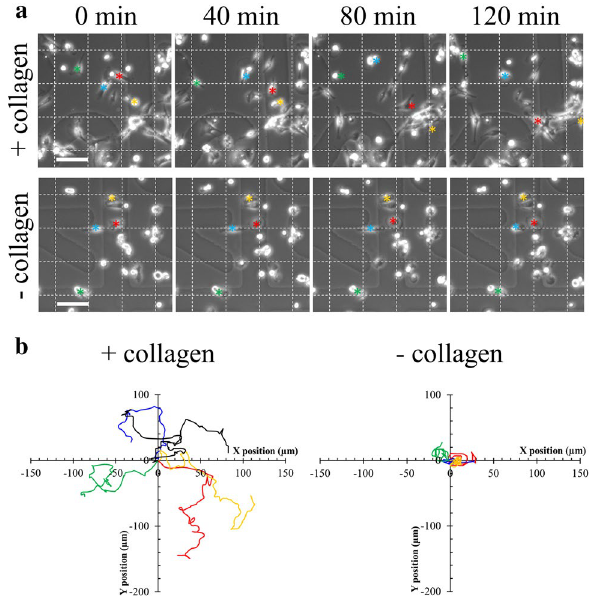
Figure 1. Effect of collagen I fibrils on the migration of MDA-MB-231 cells. ( a ) Kinetics studies by phase- contrast video-microscopy of MDA-MB-231 cells seeded on a glass coverslip coated (top panel) or not (bottom panel) with collagen I. Asterisks (red, blue, green, yellow) correspond to the position of cells of interest in the course of time. Scale bar: 100 µm. ( b ) Tracking analysis of cells presented in ( a ) was performed using MTrackJ plugin from ImageJ software. Relative position of cells migrating during two hours on glass coverslip coated (left panel) or not (right panel) with collagen I was plotted. For the sake of clarity, only four and six tracks were presented in the absence or presence of collagen, respectively. Color tracks correspond to cells marked with asterisk in ( a